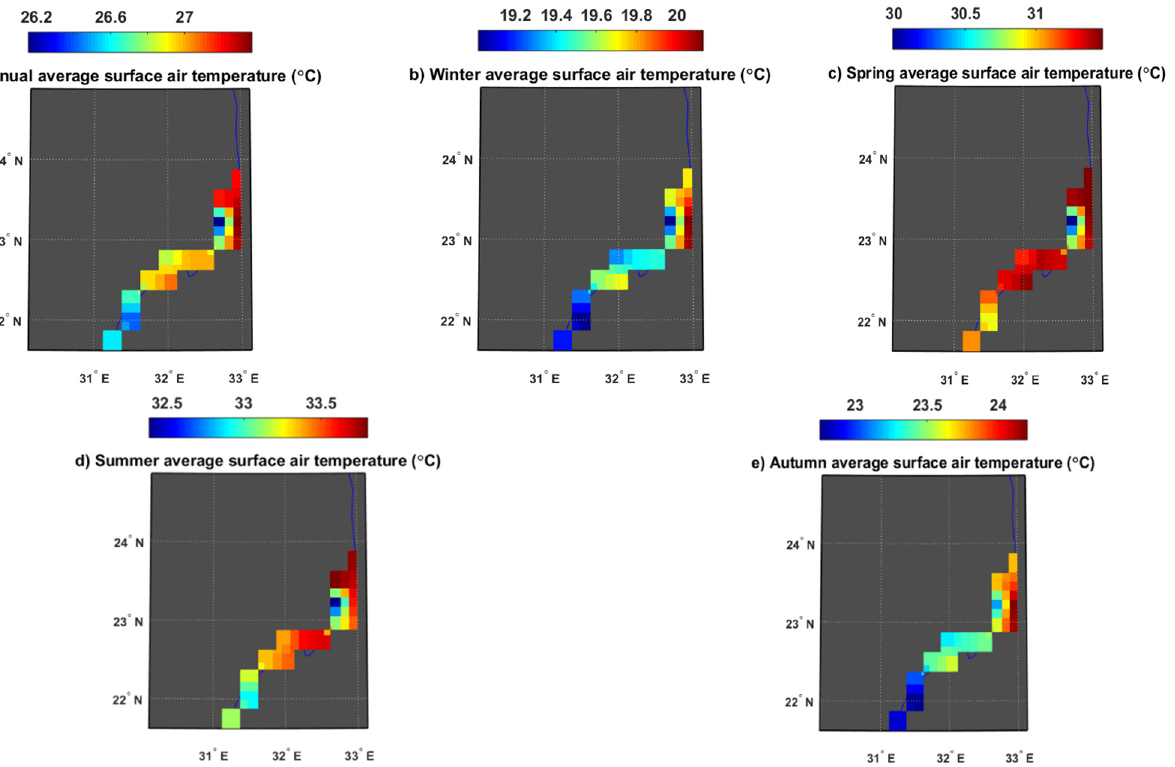
Figure 18. Spatial distribution of the mean annual/seasonal Aswan High Dam Reservoir t2m over the period from 1979 to 2018.